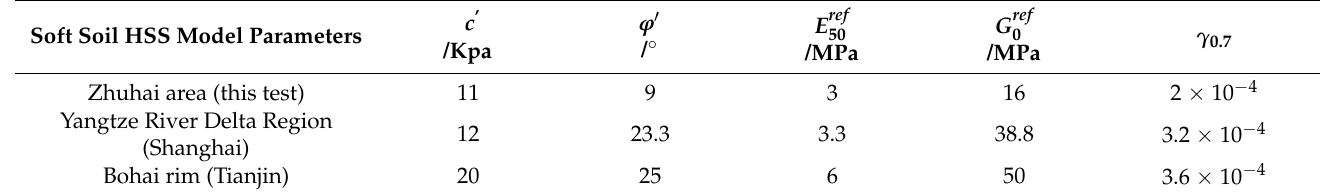
Table 4. Comparison of HSS model